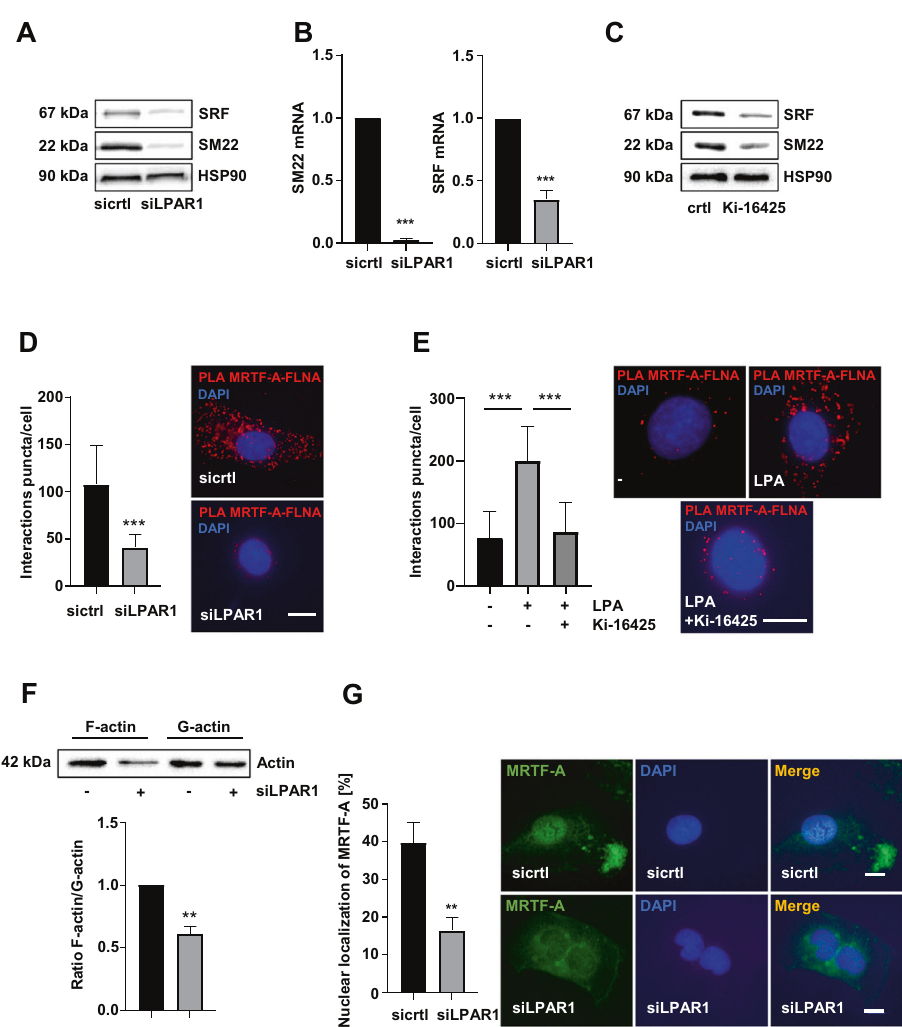
Fig. 2 LPAR1 regulates MRTF-A localization and MRTF/SRF target gene expression. A HuH7 cells transiently transfected with LPAR1 (siLPAR1) and negative control (sicrtl) siRNA were subjected to immunoblotting for SM22, SRF, and HSP90 antibodies. B HuH7 cells treated as described above were subjected to qRT-PCR using SM22 and SRF primers. Values are mean ± SD ( n = 3); *** p < 0.001. C Immunoblotting for SRF, SM22, and HSP90 in lysates of HuH7 cells treated with or without Ki-16425 (20 µM). D Immuno fl uorescence analysis and quanti fi cation of proximity ligation assay for endogenous MRTF-A and FLNA in HuH7 cells expressing LPAR1 siRNA (siLPAR1) and negative control siRNA (sictrl). DAPI was used for nuclei staining. Scale bar: 10 µm. Values are mean ± SD ( n = 3); *** p < 0.001. E Quanti fi cation of proximity ligation assay for endogenous MRTF-A and FLNA in HepG2 cells, which were untreated or treated with LPA (20 µM) for 30 min upon pre-incubation with or without Ki-16425 (20 µM) for 45 min. Scale bar: 10 µm. Values are mean ± SD; ( n = 3); *** p < 0.001. F Immunoblotting of HuH7 cells transiently transfected with LPAR1 siRNA (siLPAR1) and negative control siRNA (sictrl) with anti-actin antibody (top). Quanti fi cation of the ratio of F/G- actin in HuH7 cells (bottom). Values are means ± SD ( n = 3); ** p < 0.01. G Statistical analysis of MRTF-A localization in HuH7 cells transfected with LPAR1 siRNA (siLPAR1) or negative control siRNA (sictrl) upon immuno fl uorescence staining with anti-MRTF-A antibody. Subcellular localization shown on the left was scored as predominantly nuclear in 100 cells per condition. Scale bar: 10 µm. Values are mean ± SD ( n = 100 fi elds of vision) ( n = 3); ** p <